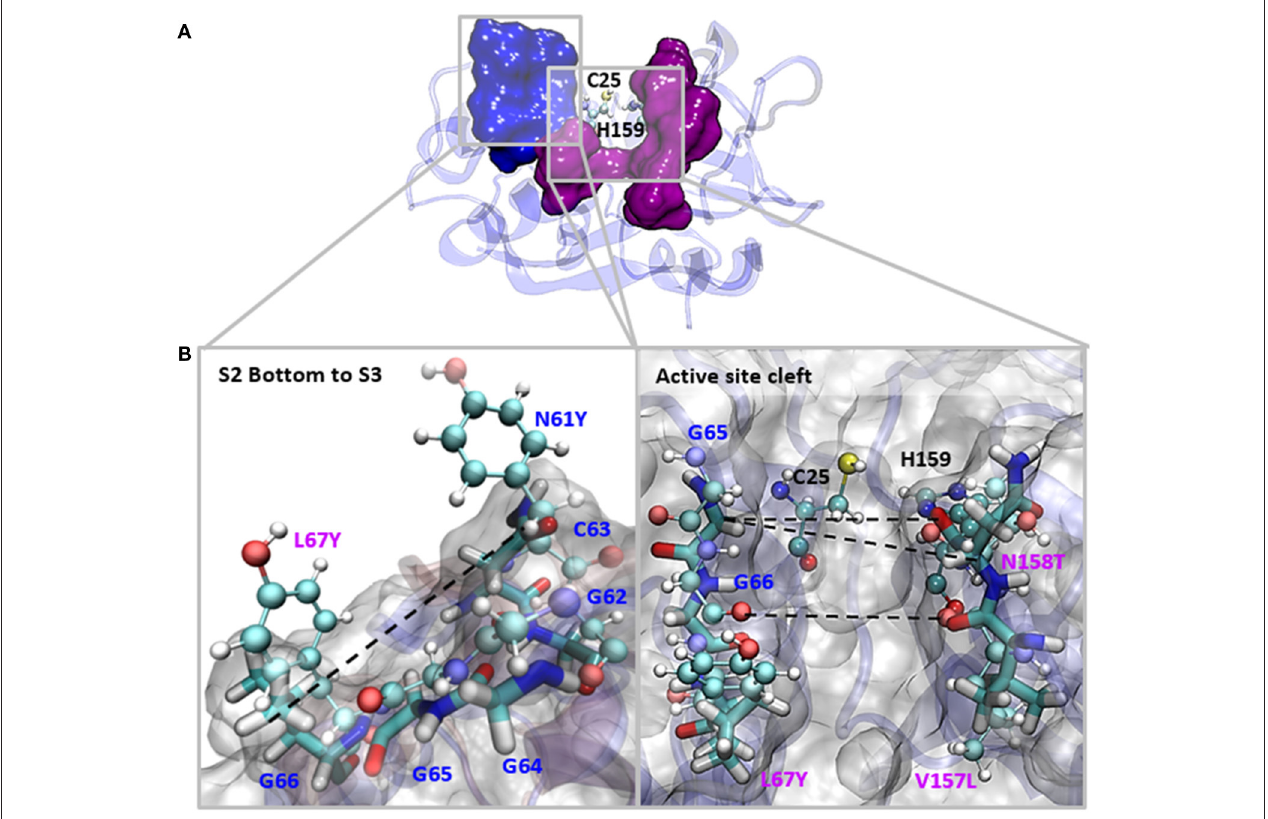
FIGURE 5 | Interatomic distances between residues in the S 2 and S 3 sites in MD simulations. (A) The most representative structure for Fh CL1 is depicted in blue new cartoons, in ball and sticks are depicted Cys25 and His159; blue surface represents the S 3 residues and pink surface represents the S 2 residues. (B) We zoomed the regions in the squares and show the measured distances with dashed lines. Blue labels show the S 3 residues and pink labels show the S 2 residues. Fh CL1 residues are depicted in sticks and Fh CL2 residues are represented in ball and